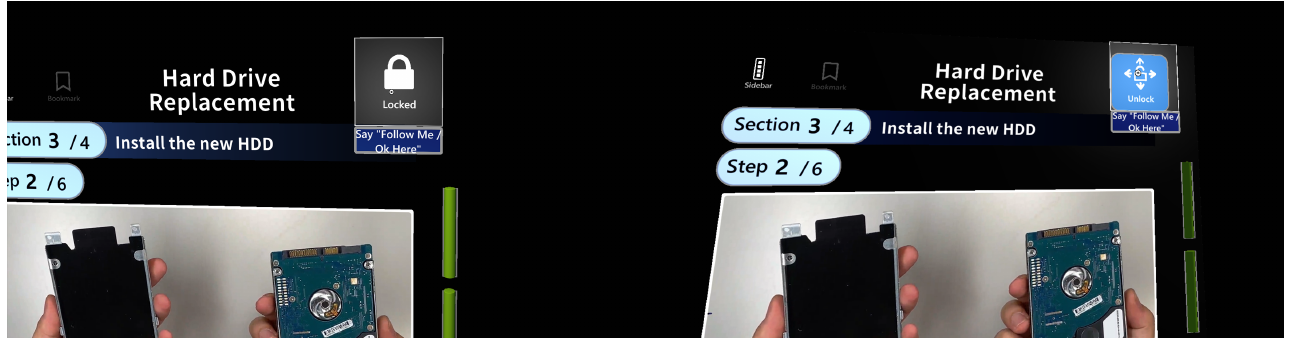
Figure 14. Fixed mode of